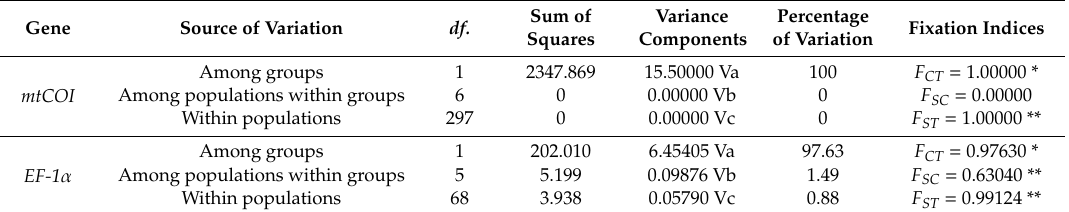
Table 3. Partitioning of genetic variation at di ff erent hierarchical